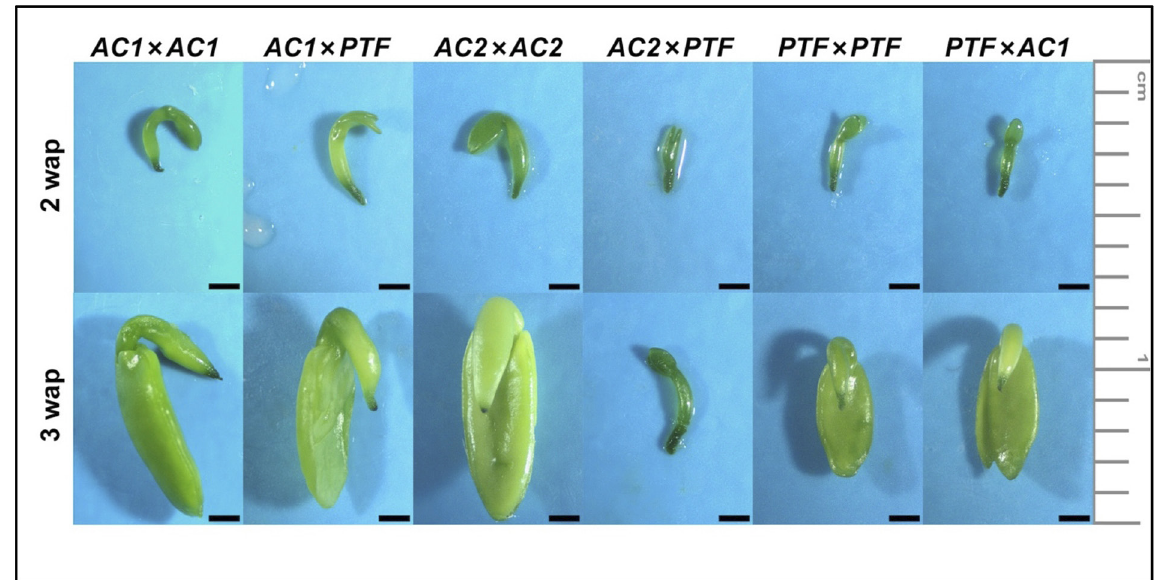
Fig. 1: Morphology of embryos deriving from selfings (control) and interspecific crossings, two and three weeks after pollination (wap), scale bar: 1 mm